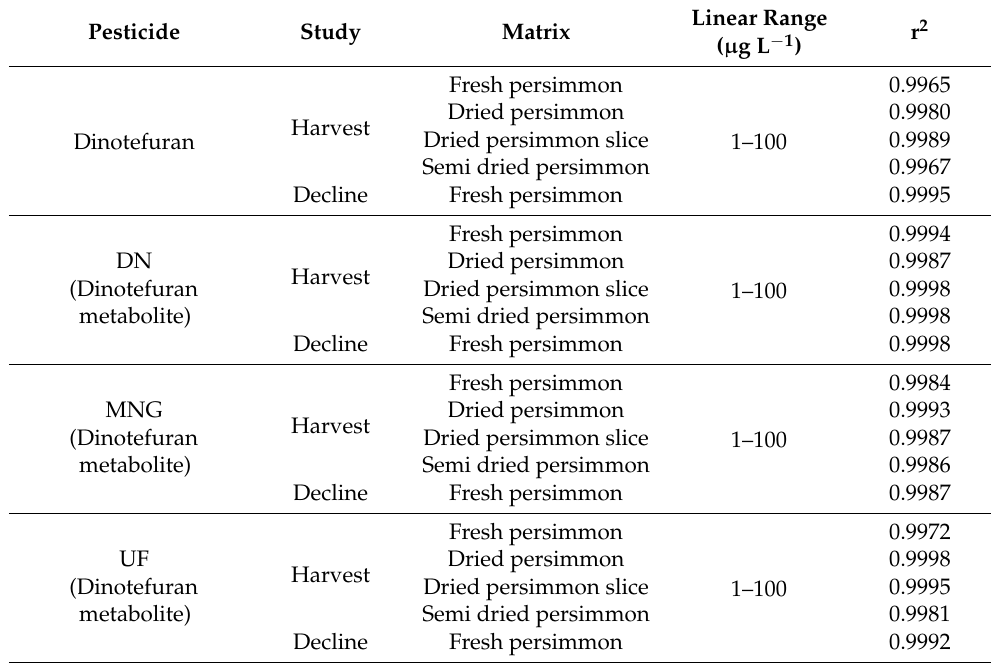
Figure 3. Chromatograms of matrix-matched standard at 100 μ g L − 1 : ( A ) Dinotefuran, ( B ) DN, ( C ) Table 3. Correlation coefficient (r 2 ) of test pesticides according to matrices for quantitation in the samples.